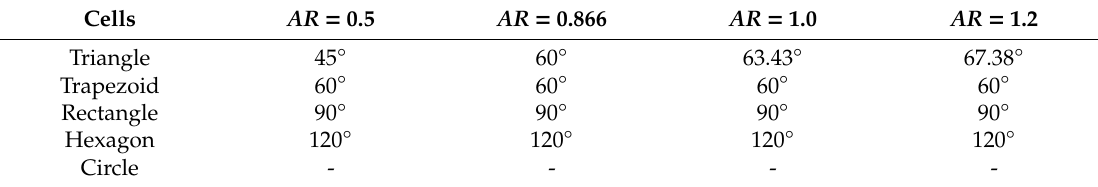
Table 1. The characteristic angles of di ff erent cells with AR = 0.5, 0.866, 1.0, and 1.2. Cells AR =